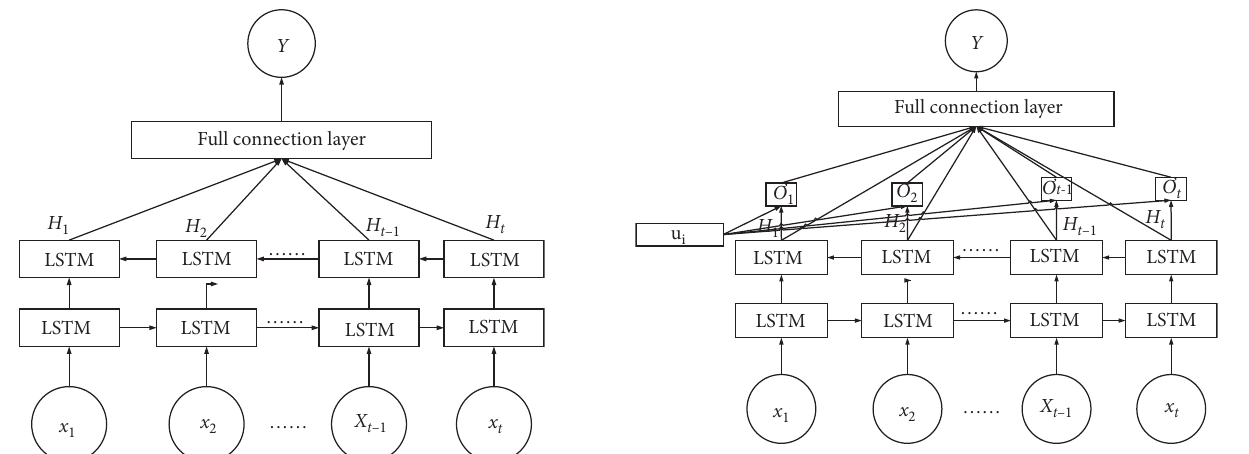
Figure 19: Schematic diagram of BiLSTM-attention.